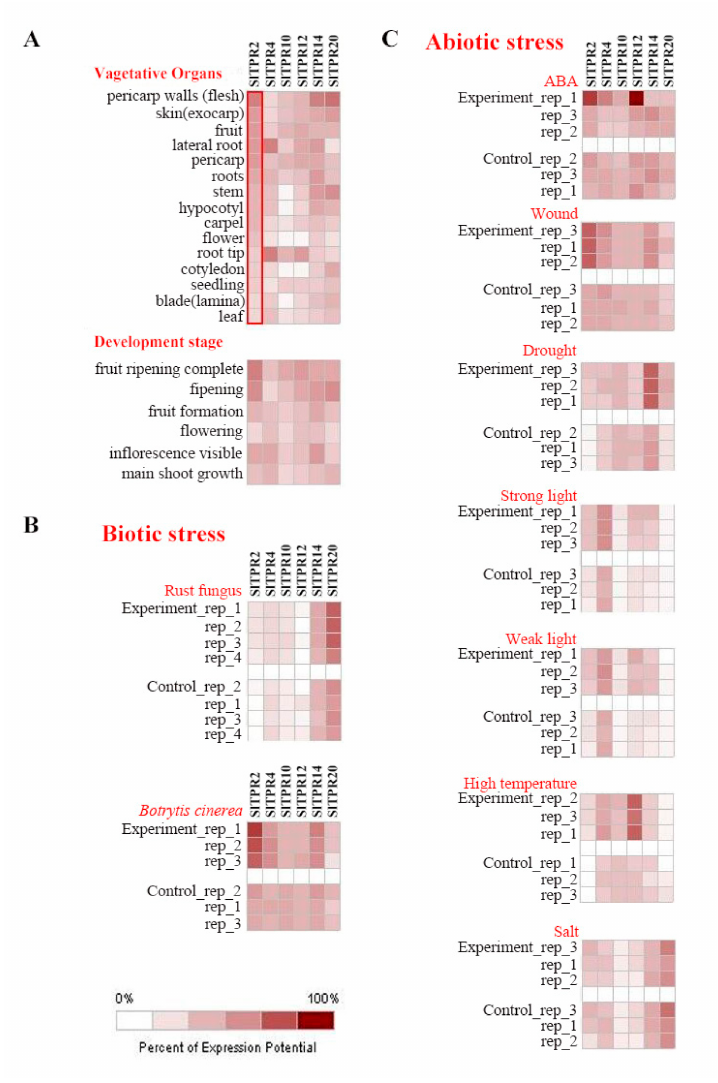
Figure 3. ( A ) Prediction and analysis of organizational positioning ( B ) Gene expression under biotic stress ( C ) Gene expression under abiotic stress. The expression pattern of the tomato TPR gene. We carried out 9 treatments on suitable tomato, including rust fungus, Botrytis cinerea, ABA, wound, drought, strong light, weak light, high temperature, salt. For rust fungus and Botrytis cinerea , the solution was diluted to 10 7 cfu/ mL and sprayed on the 4-week-old seedlings. For ABA treatment, the concentration of the solution is 0.15 mM. For wound treatment, we use a punch to treat tomato leaves. All the four treatments were sampled at 72 h. For drought treatment, we sampled at 7 days. The strong light intensity was 1000 umol m − 2 s − 1 , the weak light intensity was 200 umol m − 2 s − 1 , and the control group was 450 umol m − 2 s − 1 . Both treatments were sampled at 14 days. For high temperature treatment, samples were taken one hour after treatment at 40 ◦ C. For NaCl treatment, the concentration of the solution is 100 mM and treatment were sampled at 24 h. All treatments were repeated at least 3